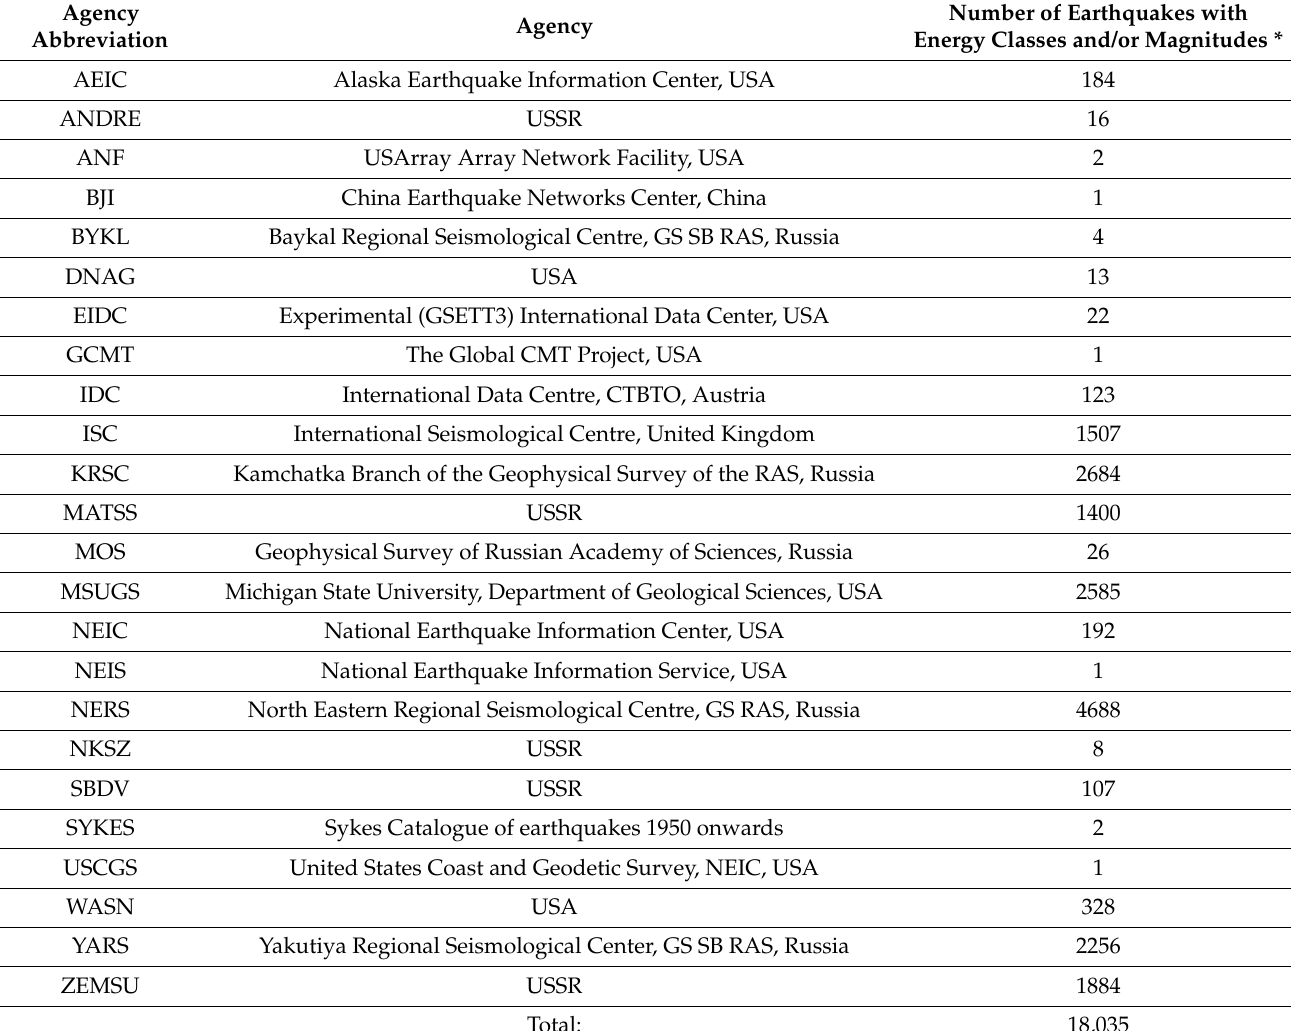
Table 2. ISC catalog statistics from